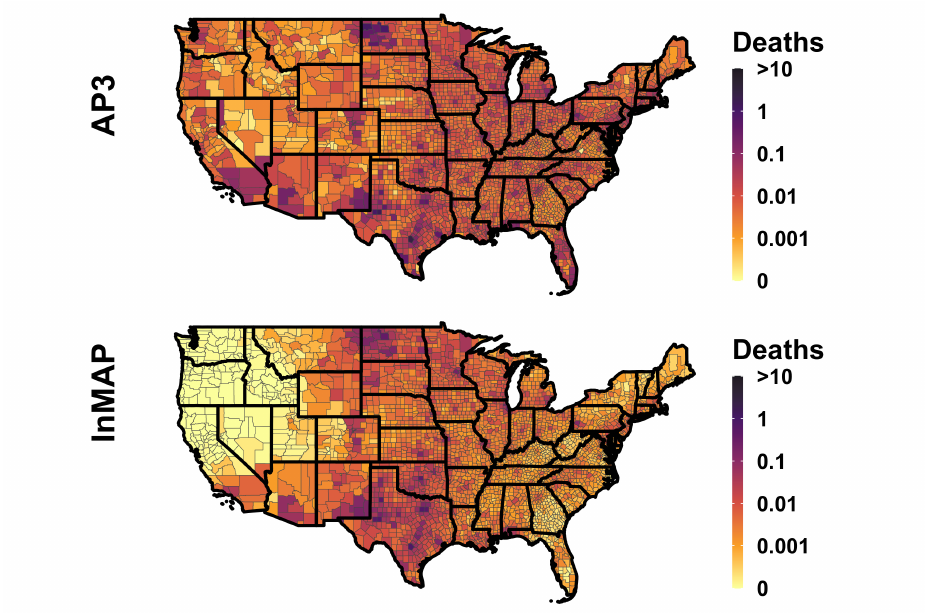
Figure 4. Spatial distribution of flaring-caused mortality in contiguous US as simulated by the AP3 ( top ) and InMAP ( bottom ) models, plotted by receptor